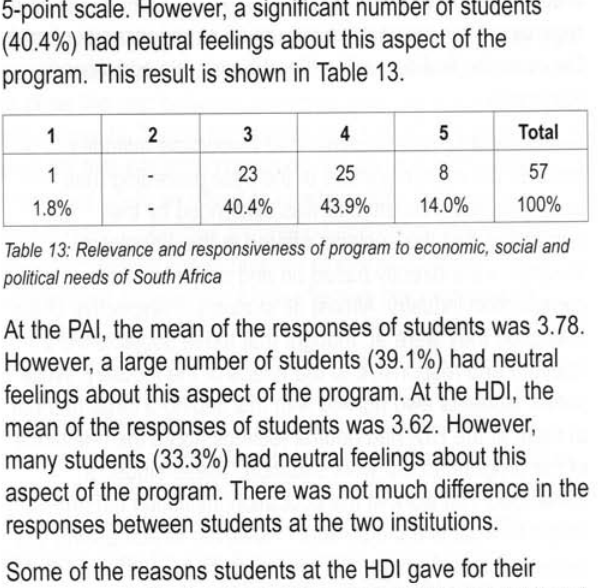
Table 13: Relevance and responsiveness of program to economic, social and political needs of South Africa At the PAl, the mean of the responses of students was